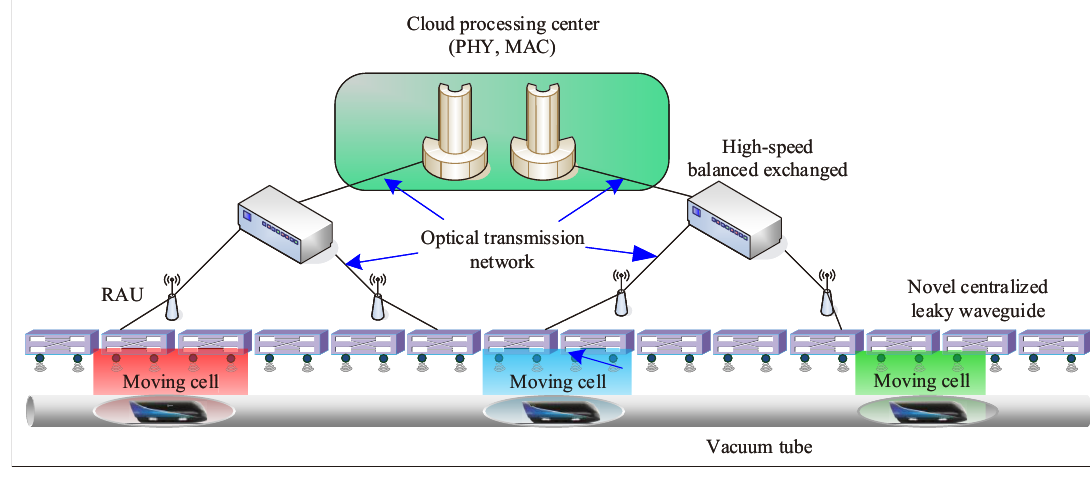
Figure 6. C-RAN system architecture for vactrain